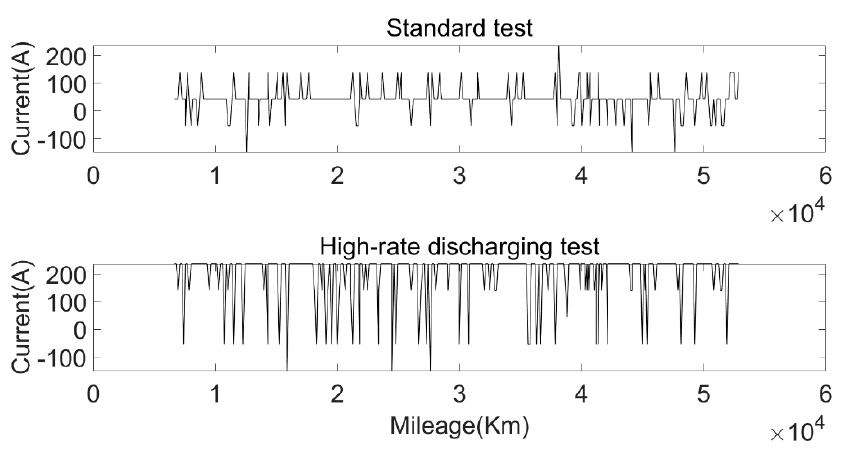
Figure 23. Variation in current with mileage under standard test environment and high-rate current test environment.